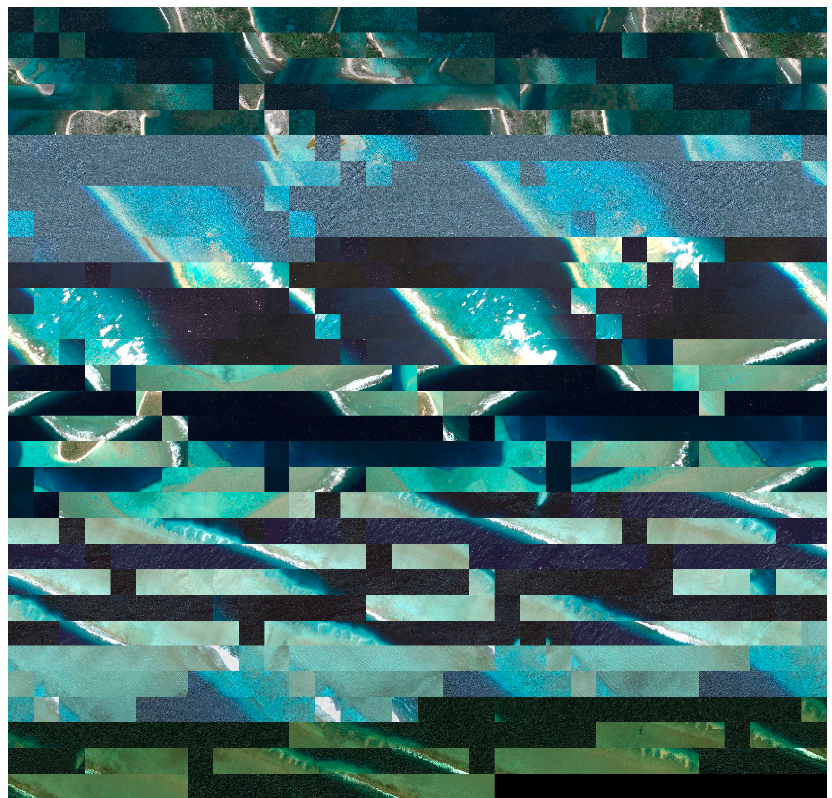
Figure 4. Using the ImageLabeler from MATLAB, 1600 images (256 × 256pixels) were labelled. The images consist of 4 Vision-1 images and 7 Google Earth images from 5 reefs (Kanton, Kenn, Kingman, Nikumamoro and Rose).